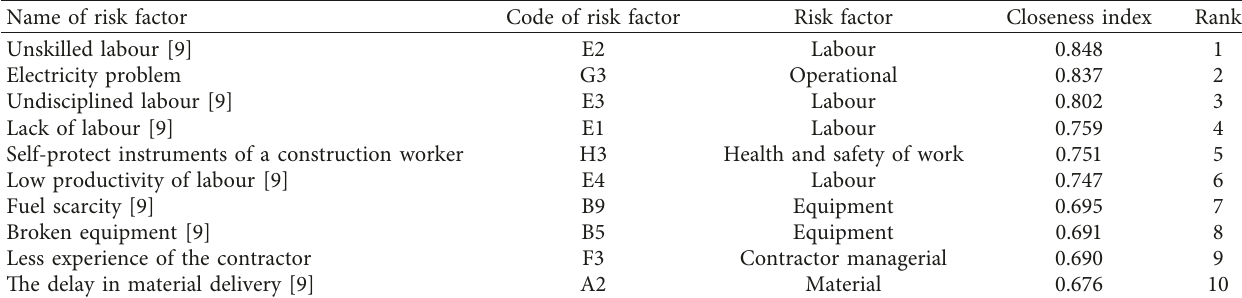
Table 3: The top ten risk